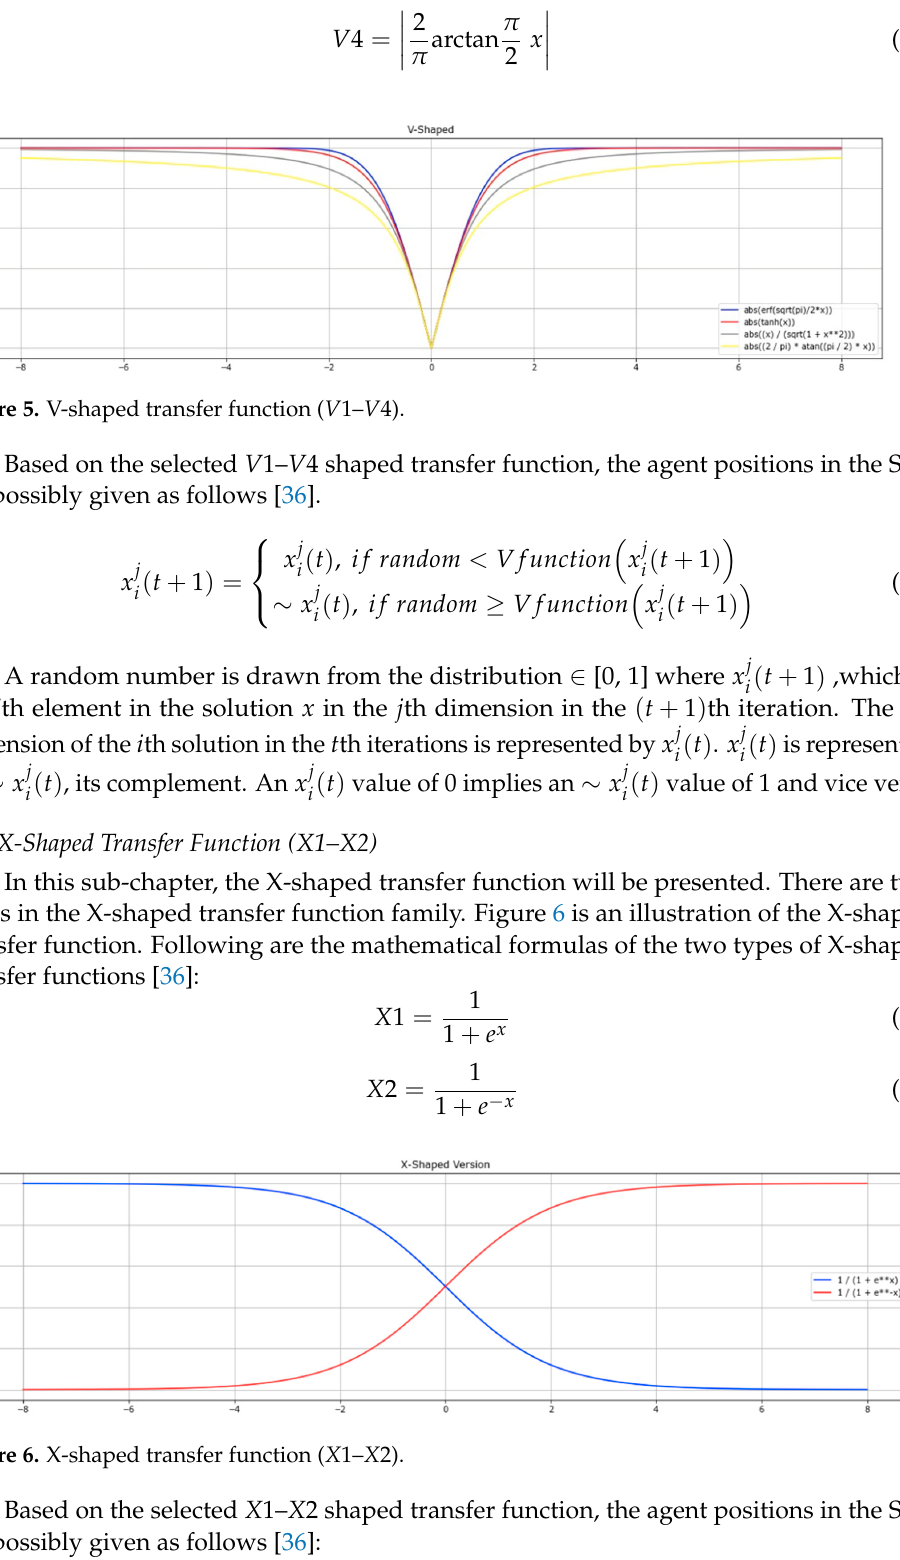
Figure 7 is an illustration of the U-shaped transfer function. Following are the mathemat-